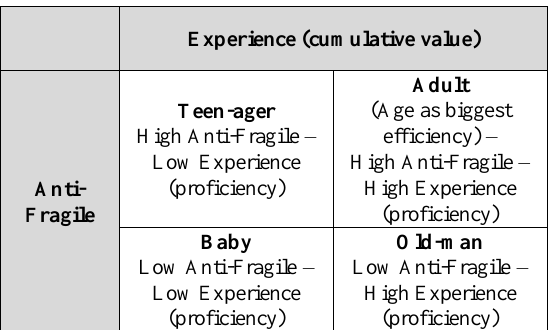
Table 1: Company Maturity